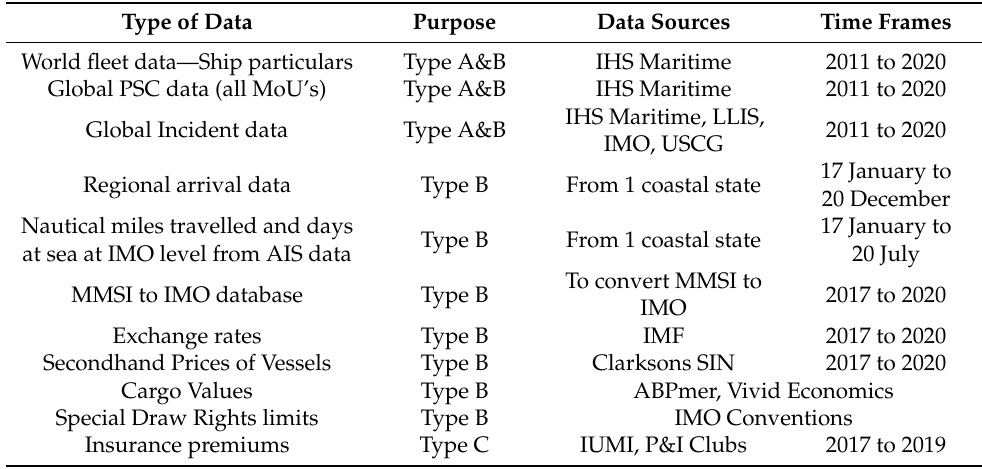
Table 1. Combination of data